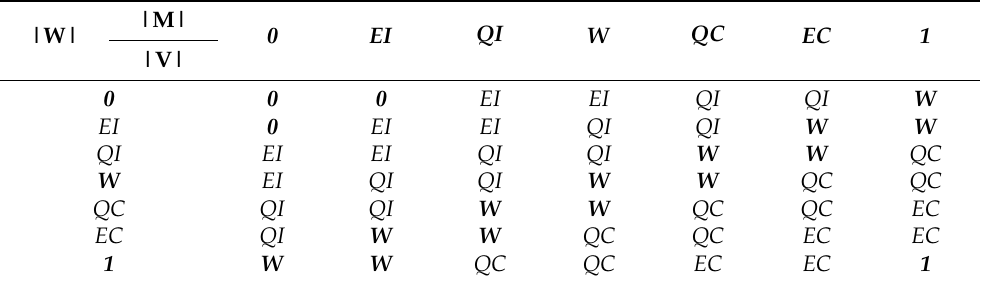
Table 5. Rule base for HA controller for | W